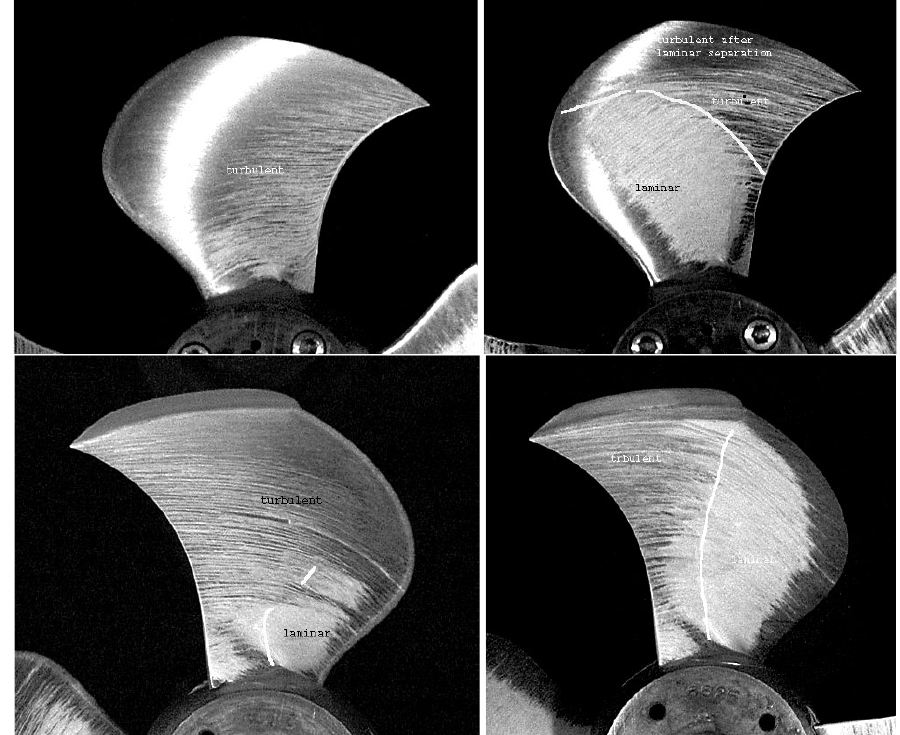
Figure 1. An example of paint test results for a CLT propeller [2]. The left frames show rough surfaces and the right frames smooth surfaces. Reproduced with permission from Juan Gonzalez-Adalid